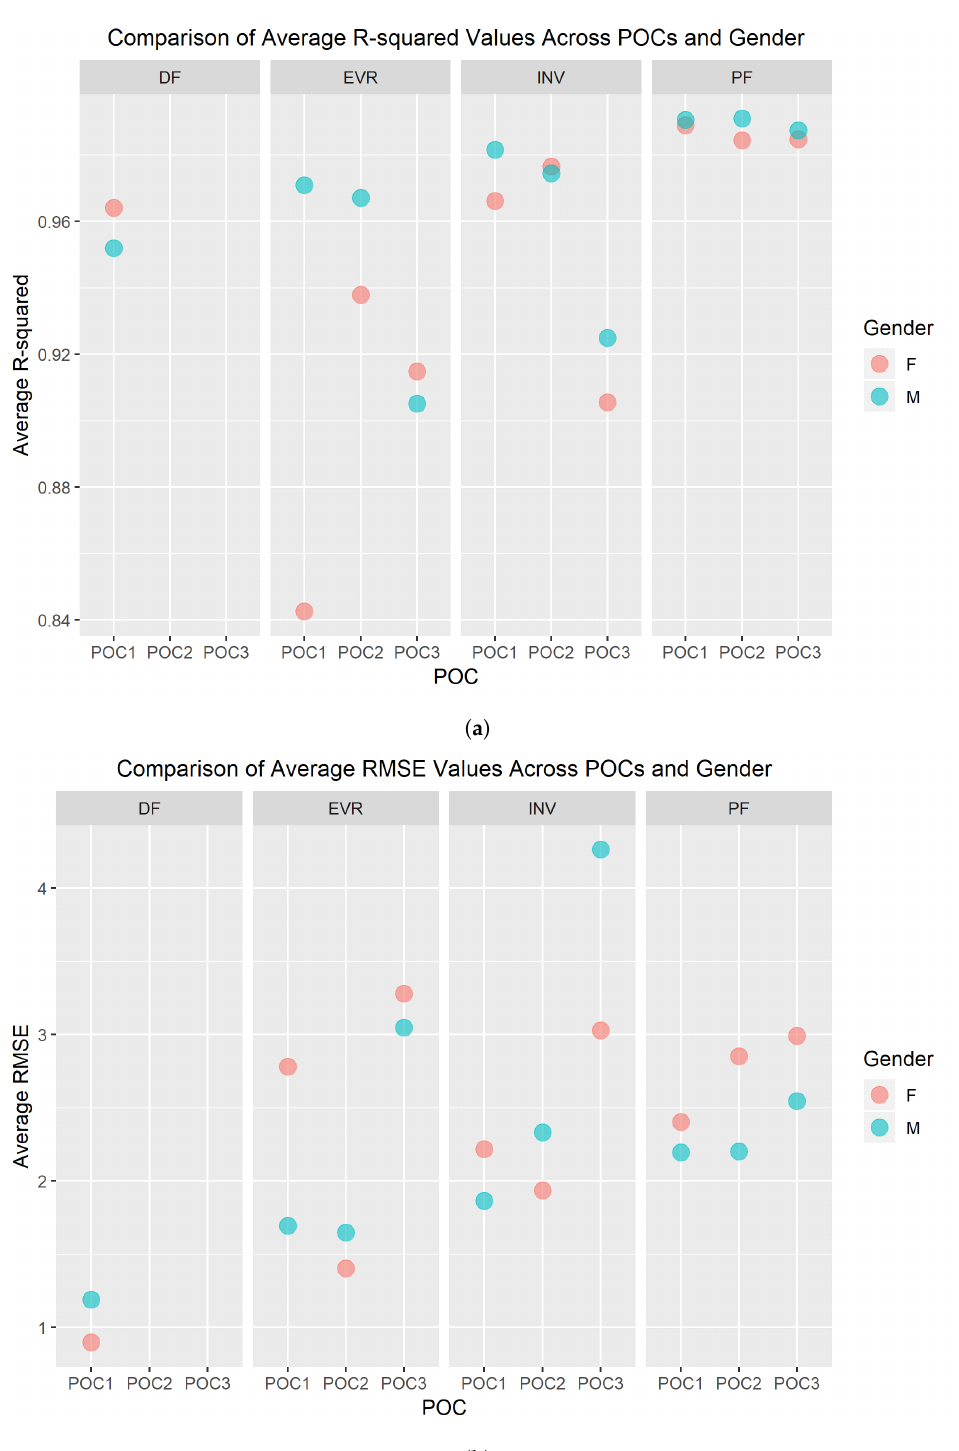
Figure 12. ( a ) Comparison of average R 2 values for all SRS between genders/foot size; and ( b ) comparison of average RMSE values for all SRS between genders/foot